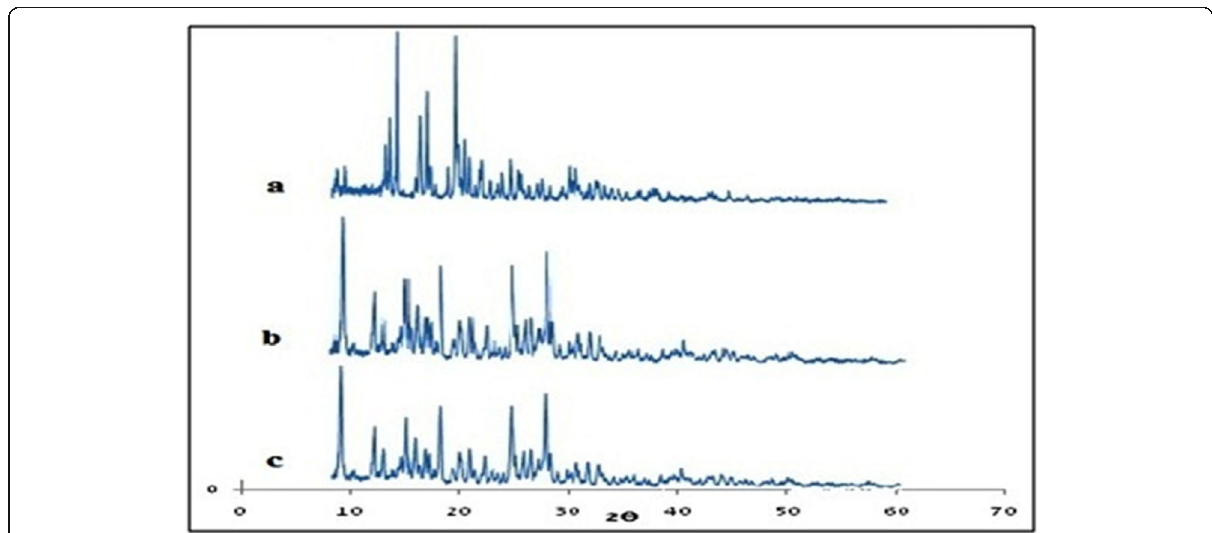
Fig. 3 PXRD pattern of a piroxicam, b sucralose, and c piroxicam